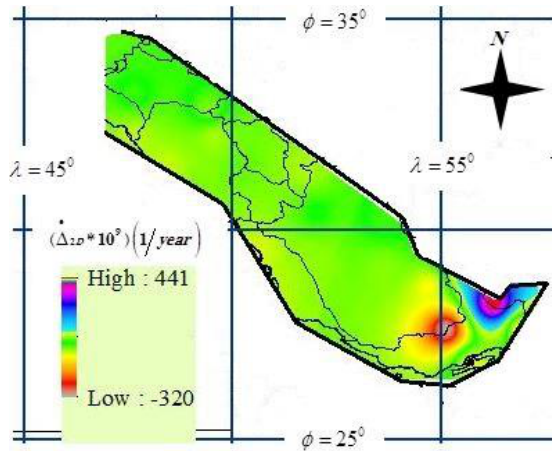
Figure 7. Changes of the 2D dilative strain rate in Zagros The 2D shear strain rate ( deformation in Zagros. This parameter does not contain the negative values.